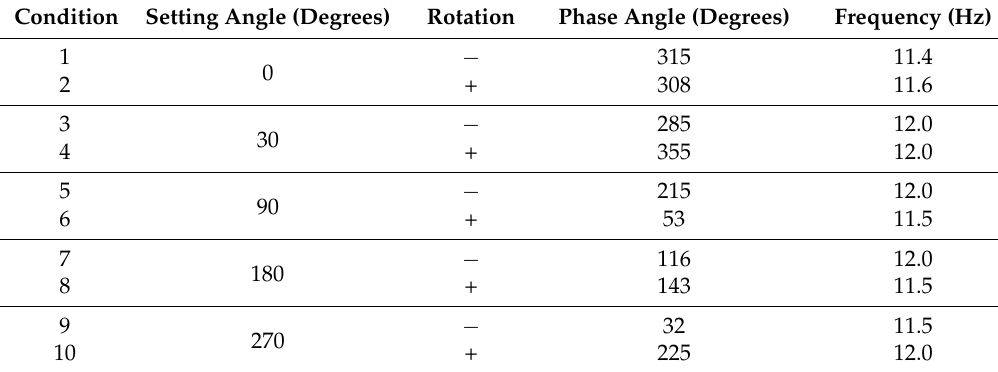
Table 2. Flapping performance in each setting angle during tethered motion. Rotation refers to the direction of motor